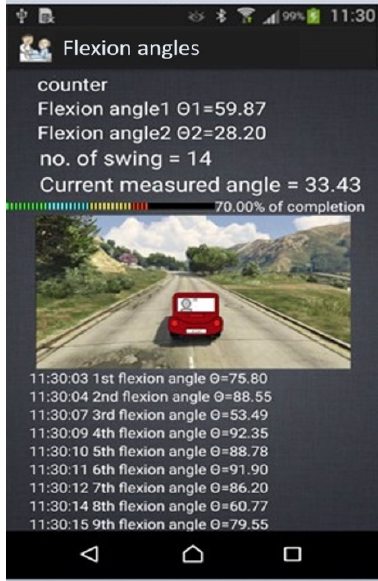
Figure 11. Rehabilitation interface.